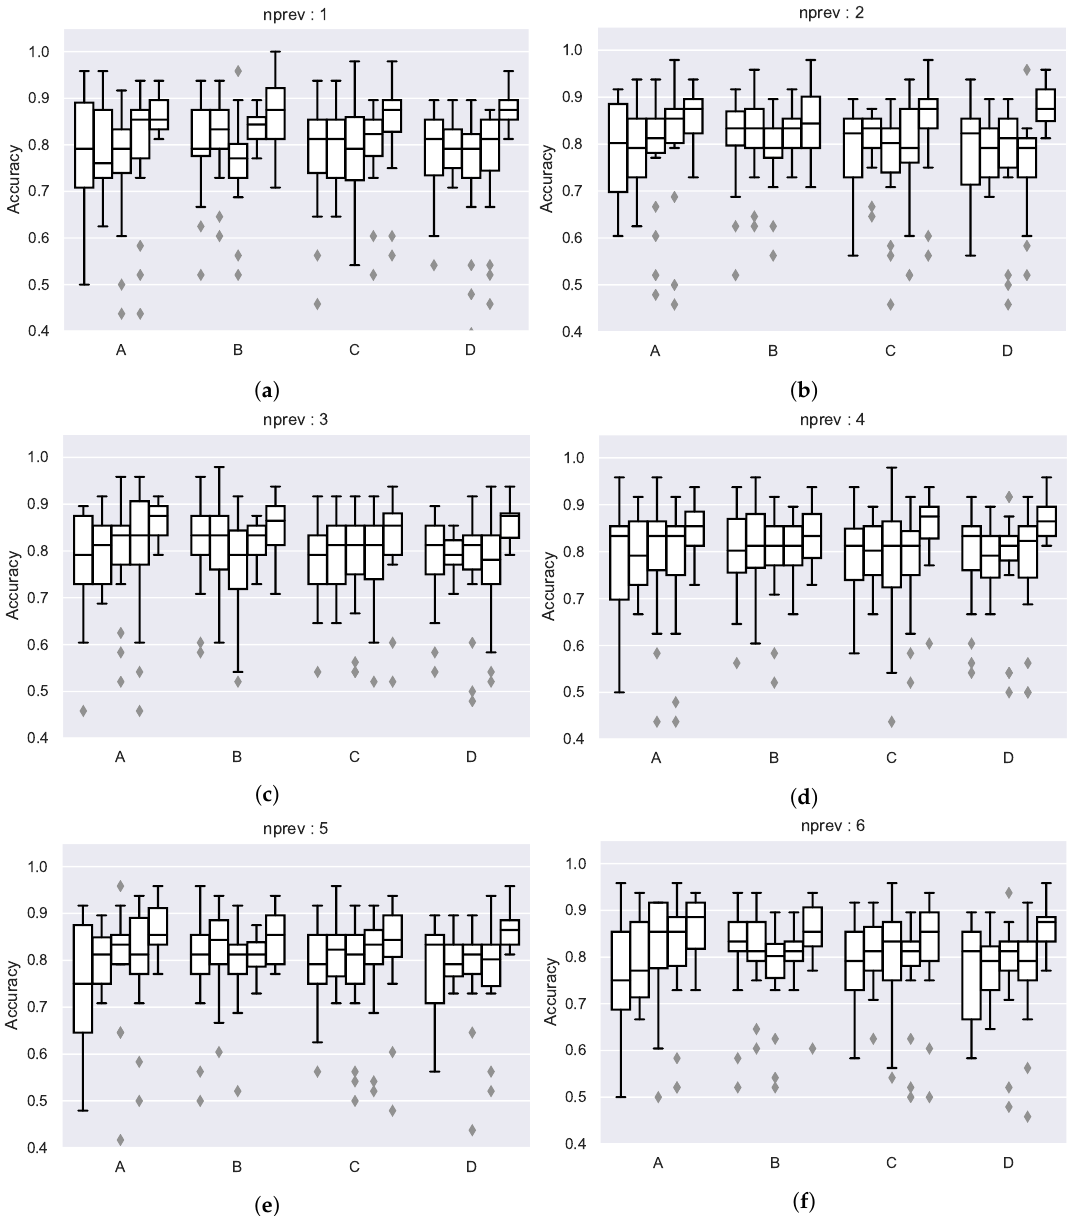
Figure 6. Accuracy scores of the predictions with the usage patterns using different number of previous weeks for constructing the patterns in each of the monitored meeting-rooms (separated per week-day, boxes are in order: Monday-Friday): ( a ) 1 week, ( b ) 2 weeks, ( c ) 3 weeks, ( d ) 4 weeks, ( e ) 5 weeks, ( f ) 6